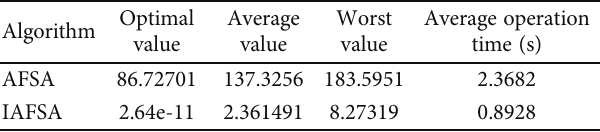
Table 4: Execution results of two optimization algorithms (function f 1 ).